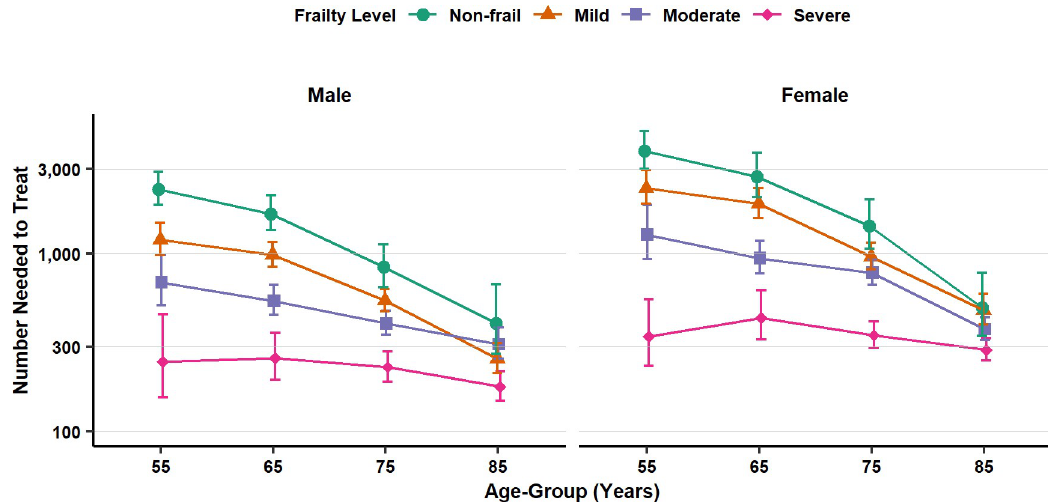
Fig 3. Number of antibiotic prescriptions required to prevent one sepsis event (NNT) following infection consultations in primary care by frailty level, gender, and age group. Figures are median estimates (95% uncertainty interval). NNT, number needed to treat.